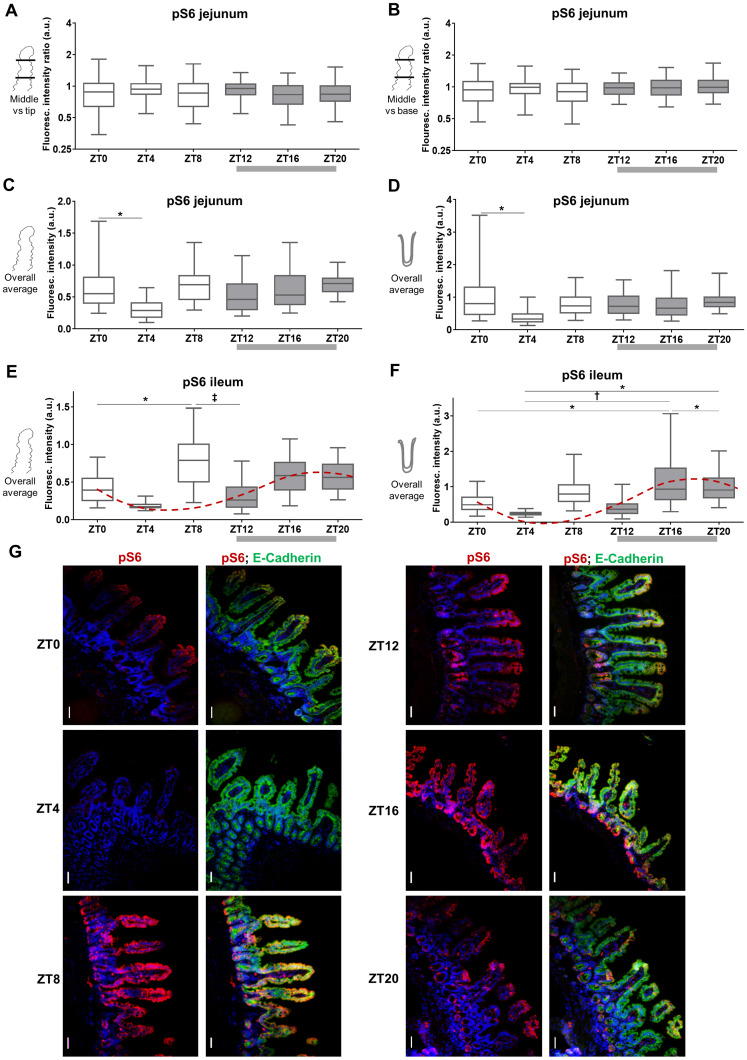
Stronger response to food-entrainment of mTOR activity in ileum than jejunum.Grey bar shows feeding period, red dotted line shows fitted cosine wave (without the ZT8 values). A: Fluorescence ratio between the middle part and tip of jejunal villi. Logarithmic scale used. 1: same fluorescence intensity on middle part and tip, >1: fluorescence intensity is increased at the middle part, <1: intensity lower at middle part. B: Fluorescence ratio between the middle part and the base of jejunal villi. C: Quantitation of fluorescence intensity of jejunal villi. D: Quantitation of fluorescence intensity of jejunal crypts. E: Quantitation of fluorescence intensity of ileal villi. F: Quantitation of fluorescence intensity of ileal crypts. A to F: villi were stained with antibody against pS6, and membrane marker E-cadherin. Fluorescence intensity determined with ImageJ 1x software and normalized to intensity of E-cadherin. Median shown, n = 110–190 (jejunal villi); n = 160–280 (jejunal crypts), n = 140–220 (ileal villi); n = 140–250 (ileal crypts) from 10–11 mice per time point from two separate experiments. Statistical analysis: One-way ANOVA with Tukey’s multiple comparison test, *p<0.05, †p<0.01, ‡p<0.001. G: Phosphorylation on S6 in mice ileum. Red: pS6, green: E-Cadherin, blue: DAPI. Scale bar: 30 μm.